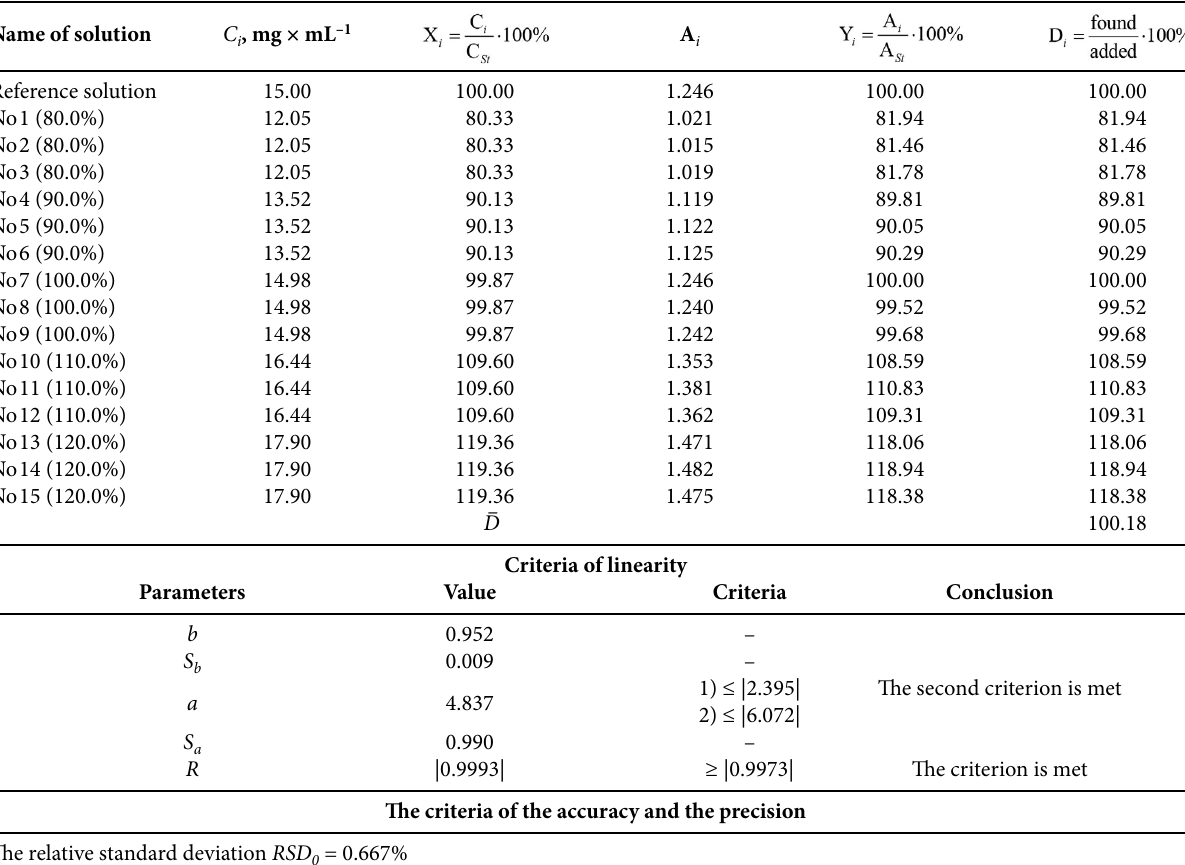
Table 8. The criteria of the linearity, the accuracy, and the precision of AM determination using STZ in the preparation of “Amoxil” tablets. Name of solution